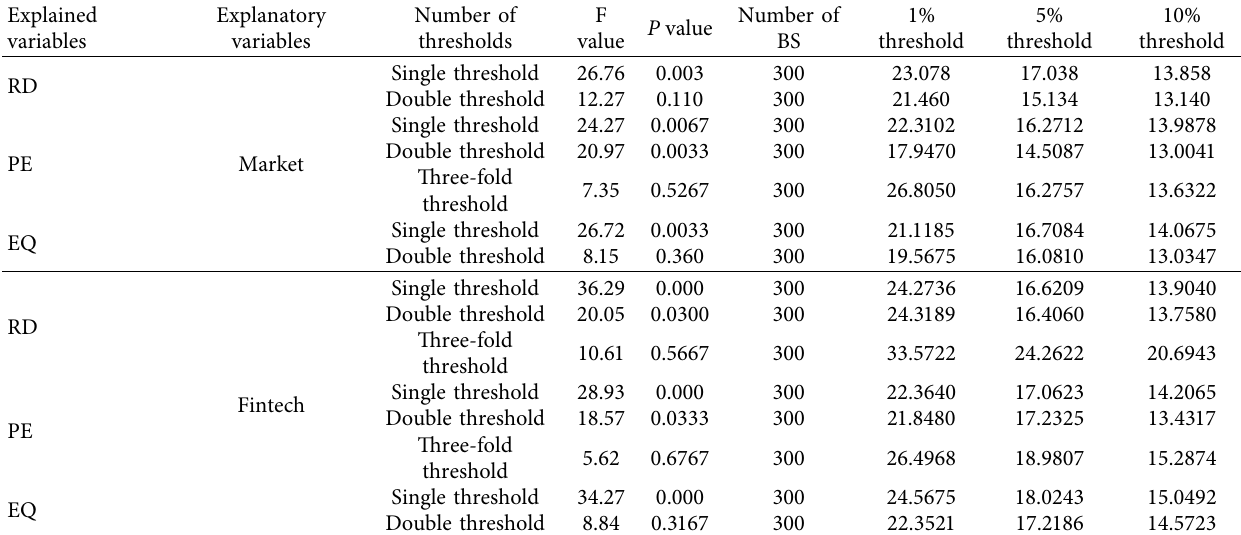
Table 7: Results of the threshold effect existence test.